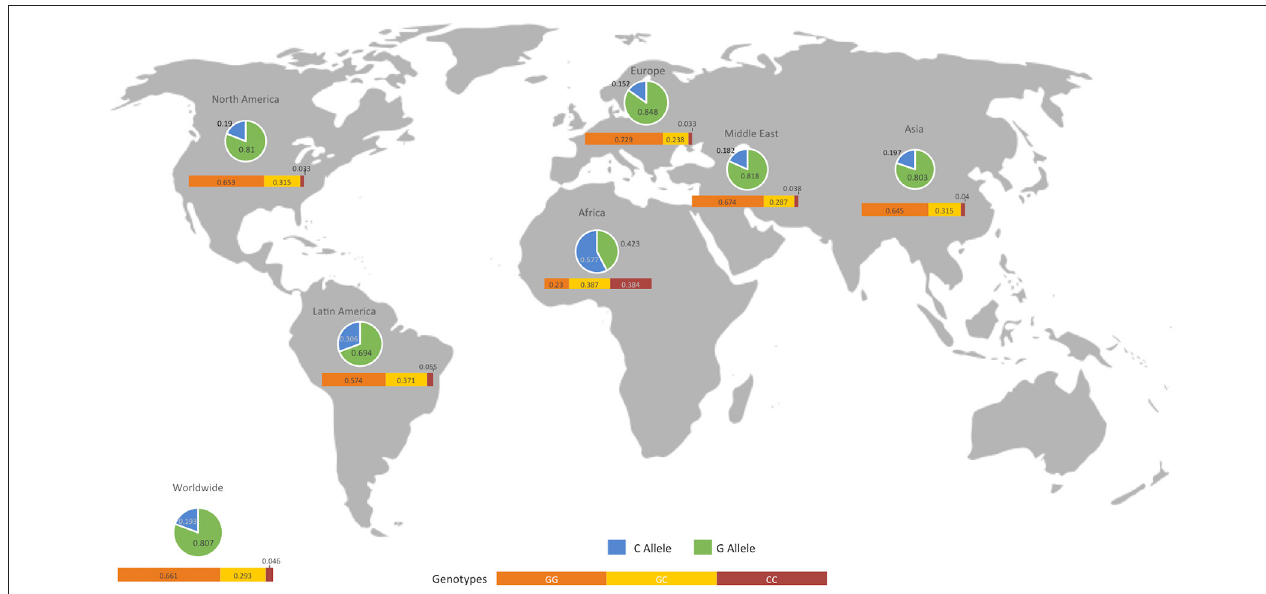
FIGURE 5 | Geographical distribution of alleles and genotypes at the MIF -173 G/C SNP. The map shows the allelic and genotypic frequencies in control individuals from all the studies included in the analysis. An extensive comparison with patients and biological databases is described in Table 5 .